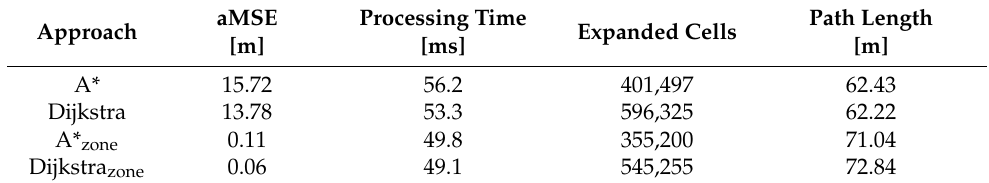
Table 1. Comparison of the evaluated planning approaches. Performance parameters averaged over 100 start-goal-position tuples in 10 simulated environments.